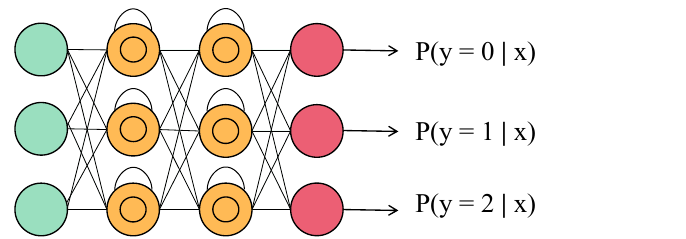
Figure 1. The LSTM models in texts.